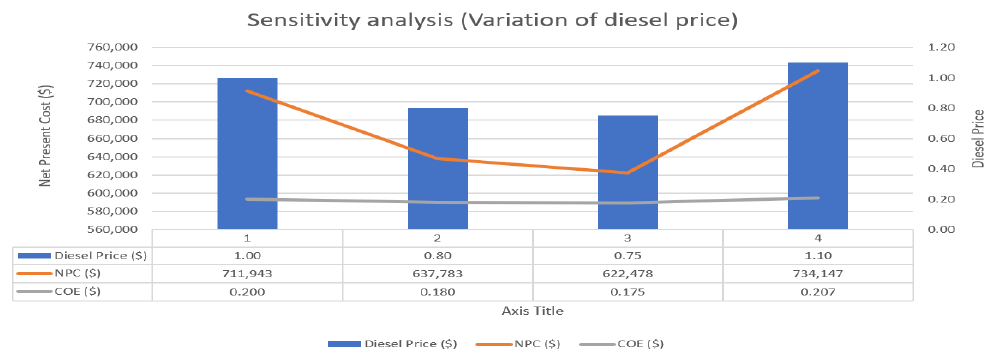
Figure 12. Variation of diesel fuel